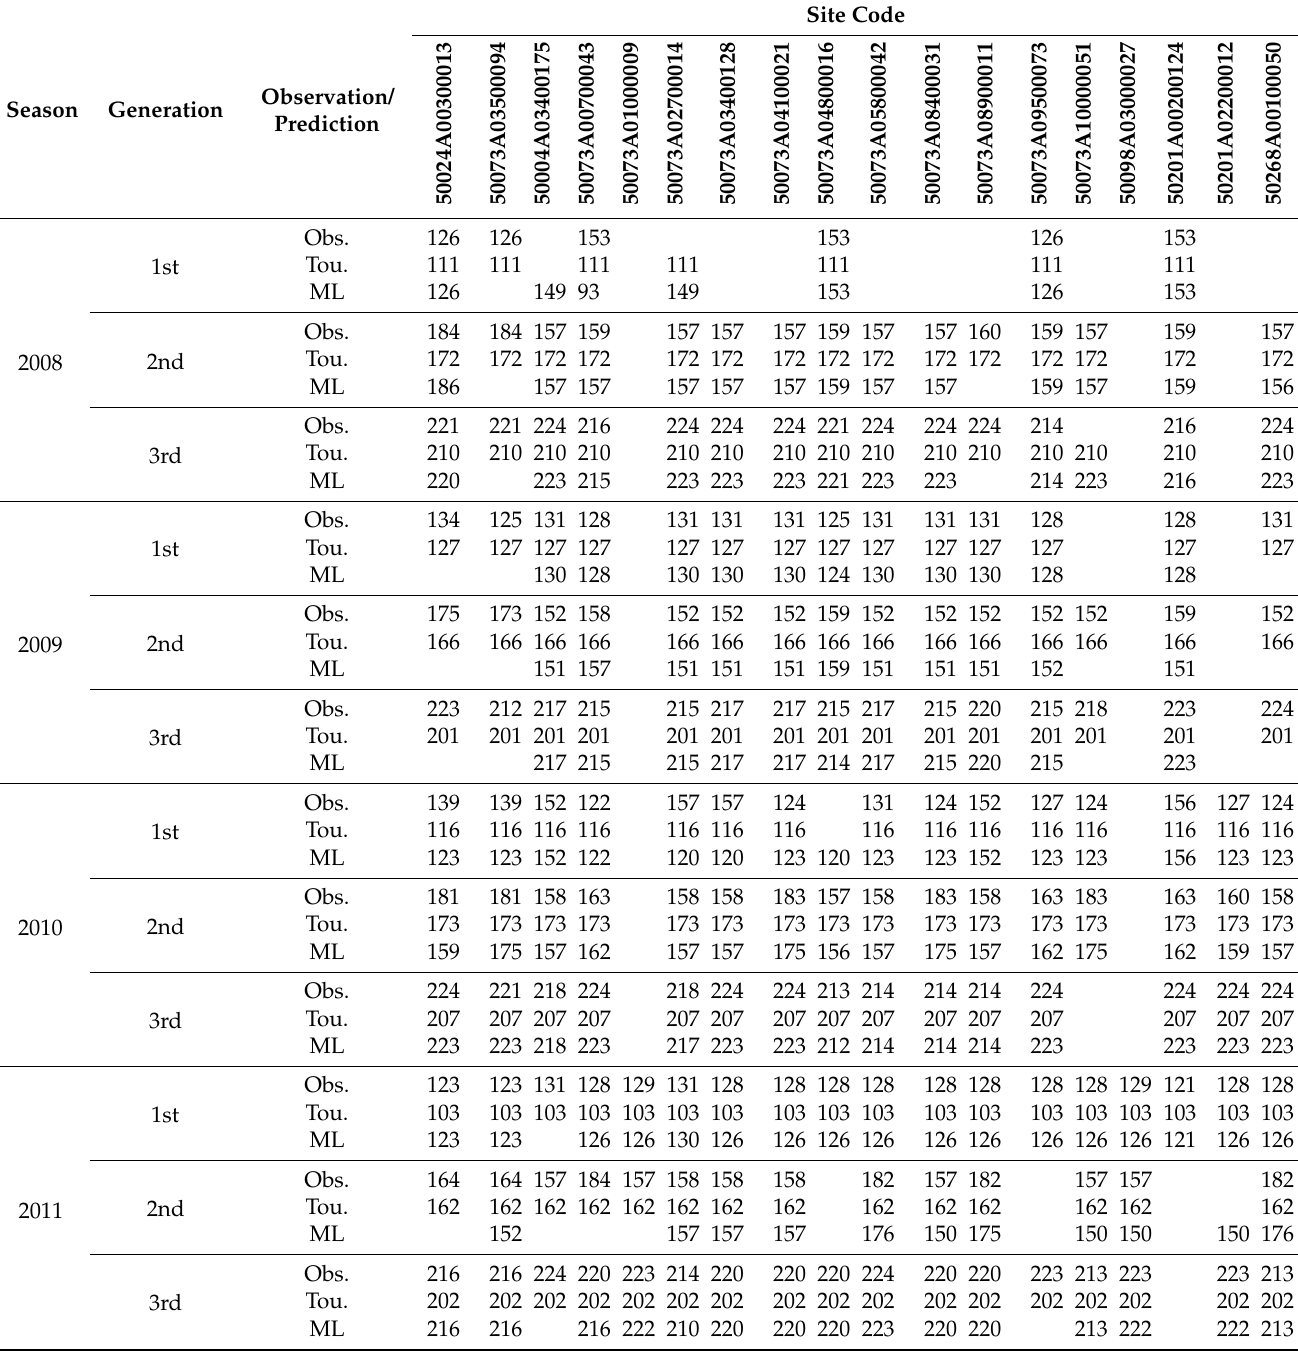
Table 2. Comparison of observed (Obs.) flight peak days of the year (DOY) with the DOY predicted by the Touzeau (Tou.) and machine learning (ML) models for the 2008 − 2011